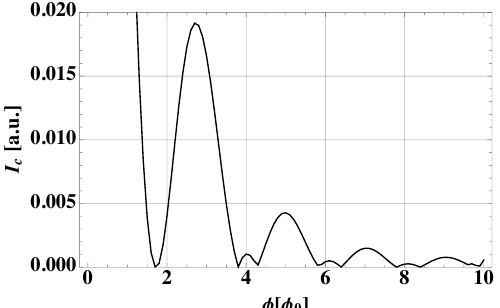
Figure 4. Resultant interference pattern I C ( φ ) in Figure 3b for a larger interval of flux